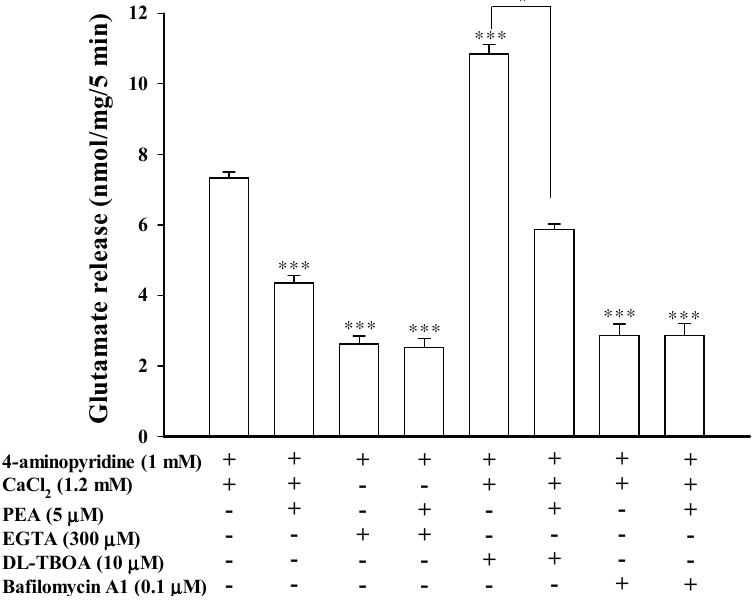
Figure 2. PEA-mediated inhibition of 4-aminopyridine-evoked glutamate release is due to a decrease in vesicular exocytosis. Bar graph showing glutamate release evoked by 1 mM 4-aminopyridine in the absence (control) or presence of 5 μ M PEA, 300 μ M